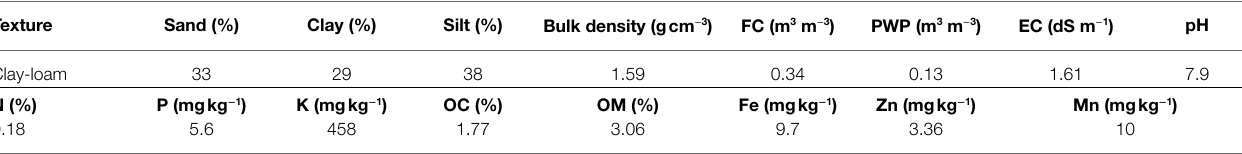
TABLE 1 | Physico-chemical properties of the soil used for growing Myrtus communis seedlings.